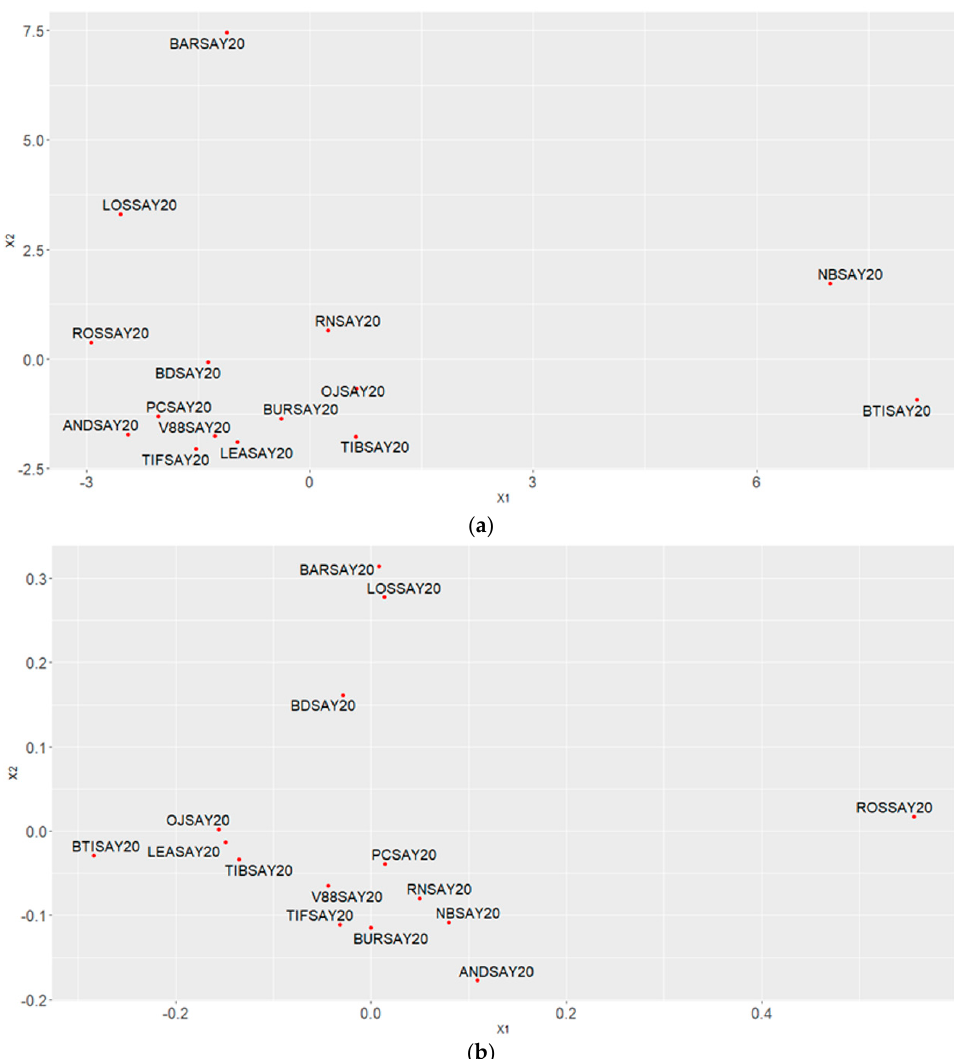
Figure A1. Multidimensional scaling using ( a ) Euclidean distance and ( b ) 1—Pearson correlation coefficient (1—cor).